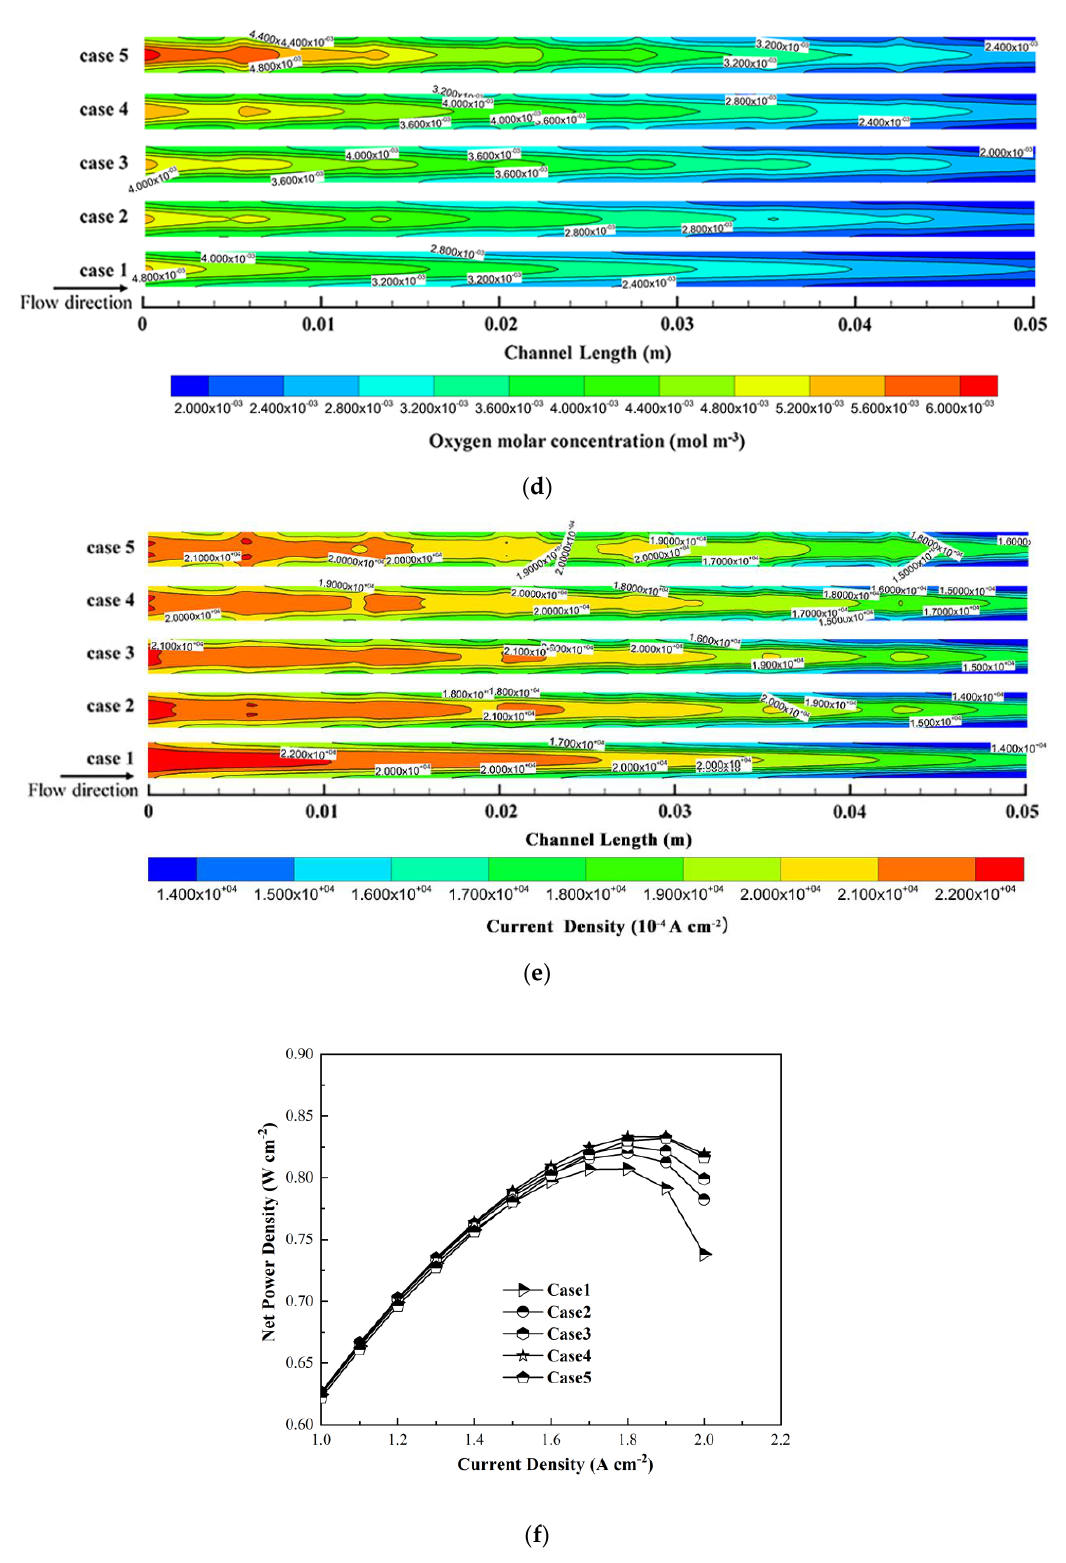
Figure 4. Performance of cases under different dimensionless heights of baffles. ( a ) Polarization curves and gross power curves. ( b ) Partially enlarged polarization curves. ( c ) Average oxygen molar concentration between GDL and CL. ( d ) Contours of oxygen molar concentration at the current density of 1.9 A · cm − 2 . ( e ) Contours of current density distribution at the current density of 1.9 A · cm − 2 . ( f ) Net power density